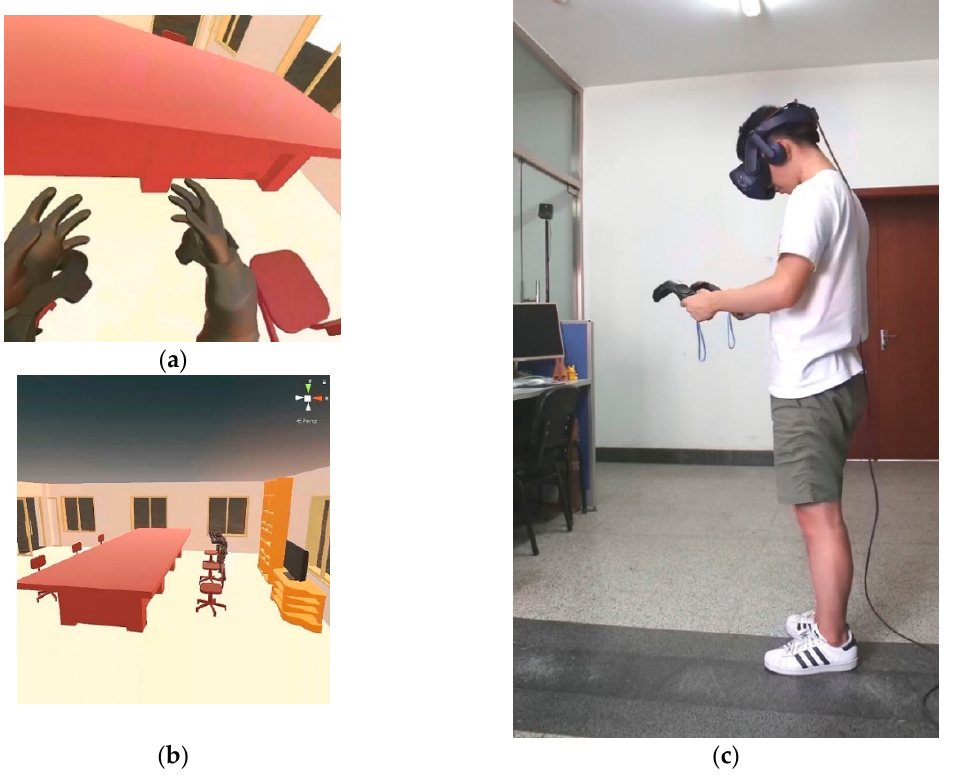
Figure 15. Framework of the virtual drill, ( a ) first-person view; ( b ) third-person view; ( c ) real drill view.